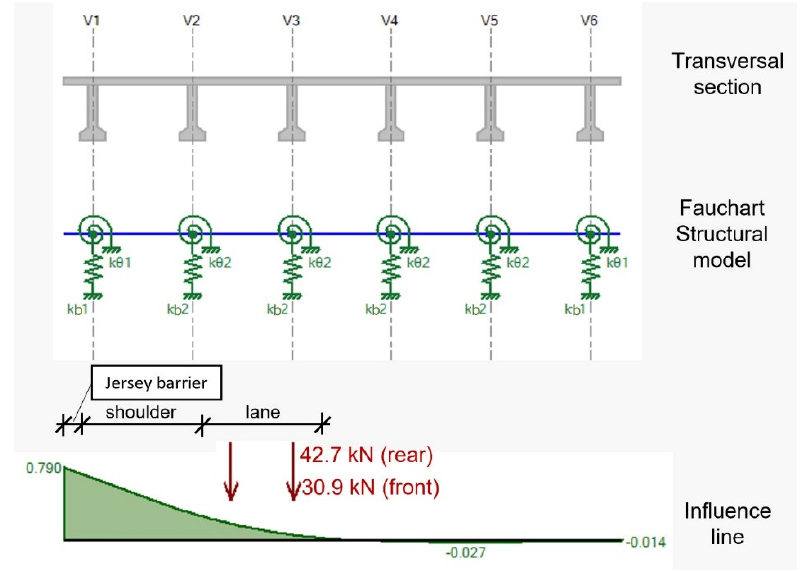
Figure 3. Transverse load distribution (scheme) according to Fauchart’s method and influence line (V1–V6 = Longitudinal girders).